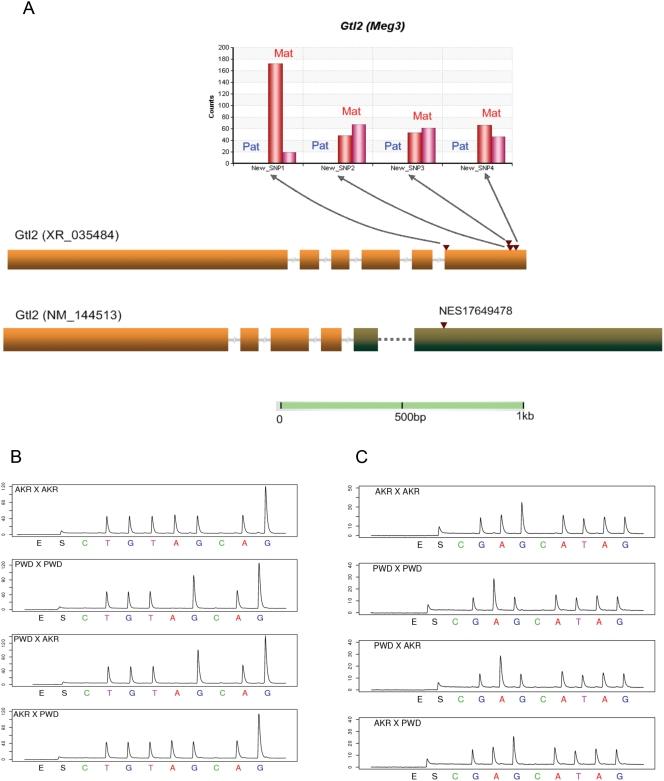
Verification for the known imprinted gene Gtl2.(A) Allele counts for the 4 new SNPs discovered by assembling the Solexa reads. The blue bars (from left to right) stand for the counts from the paternal allele in PWD x AKR and AKR x PWD F1s respectively. The red bars represent the maternal allele counts. Four novel SNPs were discovered in one Gtl2 transcript (XR_035484), consistent with monoallelic expression from the maternal allele in both reciprocal crosses and confirmed by Pyrosequencing. Another splicing variant of Gtl2, NM_144513, previously was found by us to be imprinted using a custom Agilent allele-specific microarray (unpublished), with an 1,847-fold difference in probe intensity in PWD x AKR cross and 793-fold in the reciprocal cross. A Perlegen SNP (NES17649478) in NM_144513 but not XR_035484 was verified by Pyrosequencing. We conclude that both XR_035484 and NM_144513 are imprinted in the neonatal brain. (B) Pyrosequencing verification for novel SNP1 in Gtl2. The target sequence is TGT(A/G)GAGGGA. (C) Pyrosequencing verification for Perlegen SNP NES17649478. The target sequence is GA(A/G)GATAG.